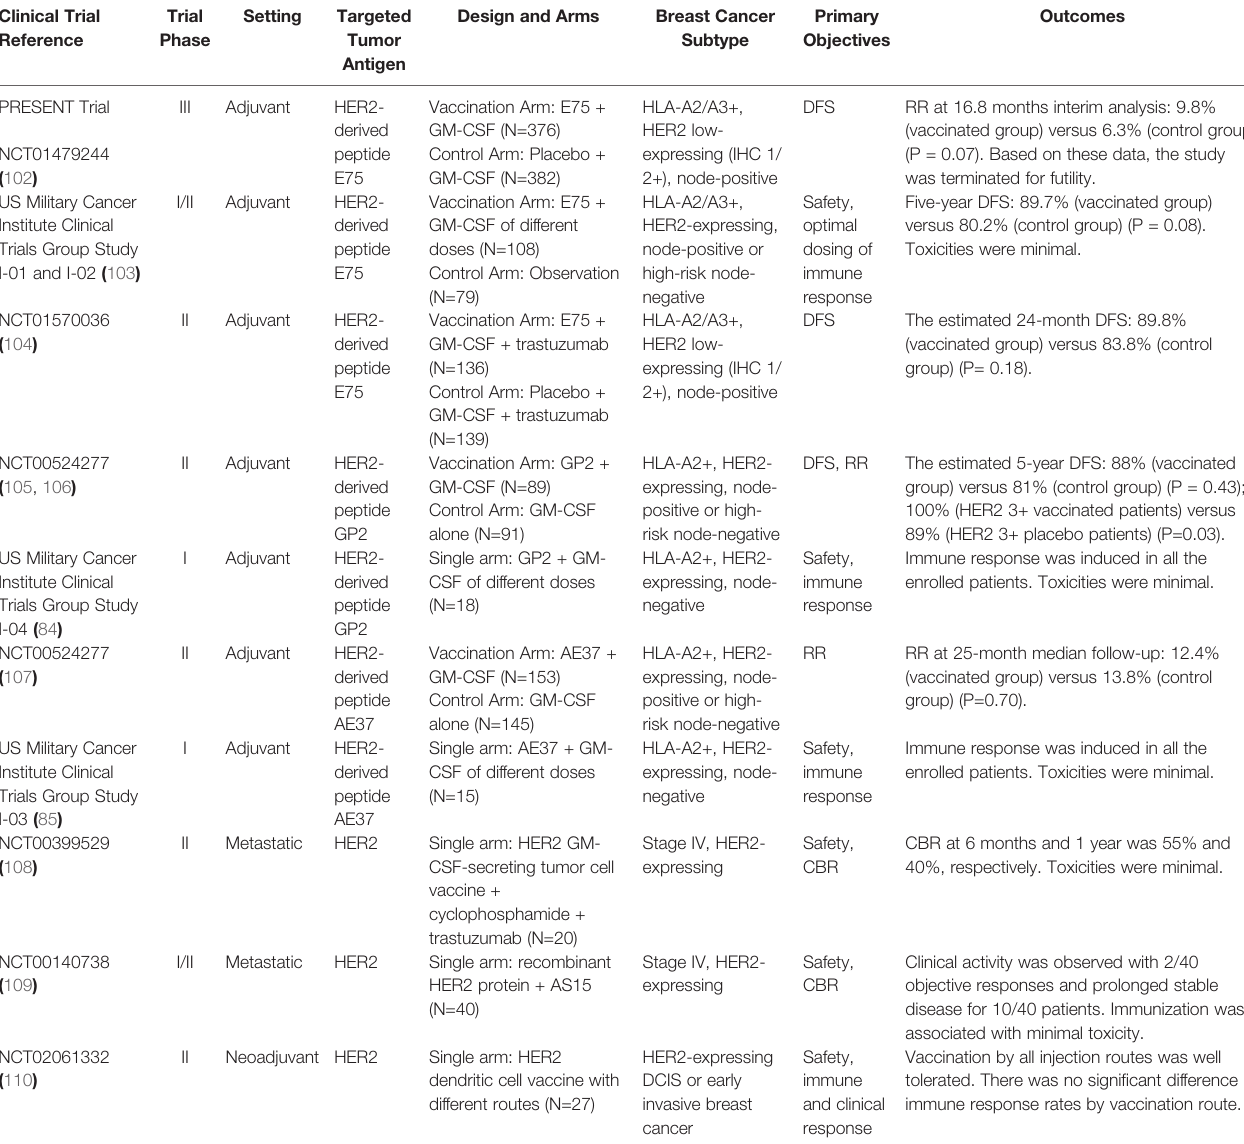
TABLE 2 | Major clinical trials on breast cancer vaccines targeting HER2-related antigens. Clinical Trial